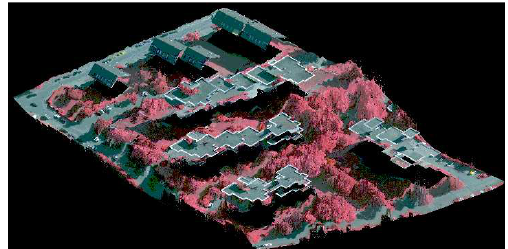
Figure 7. Figure shows the isometric view from the area